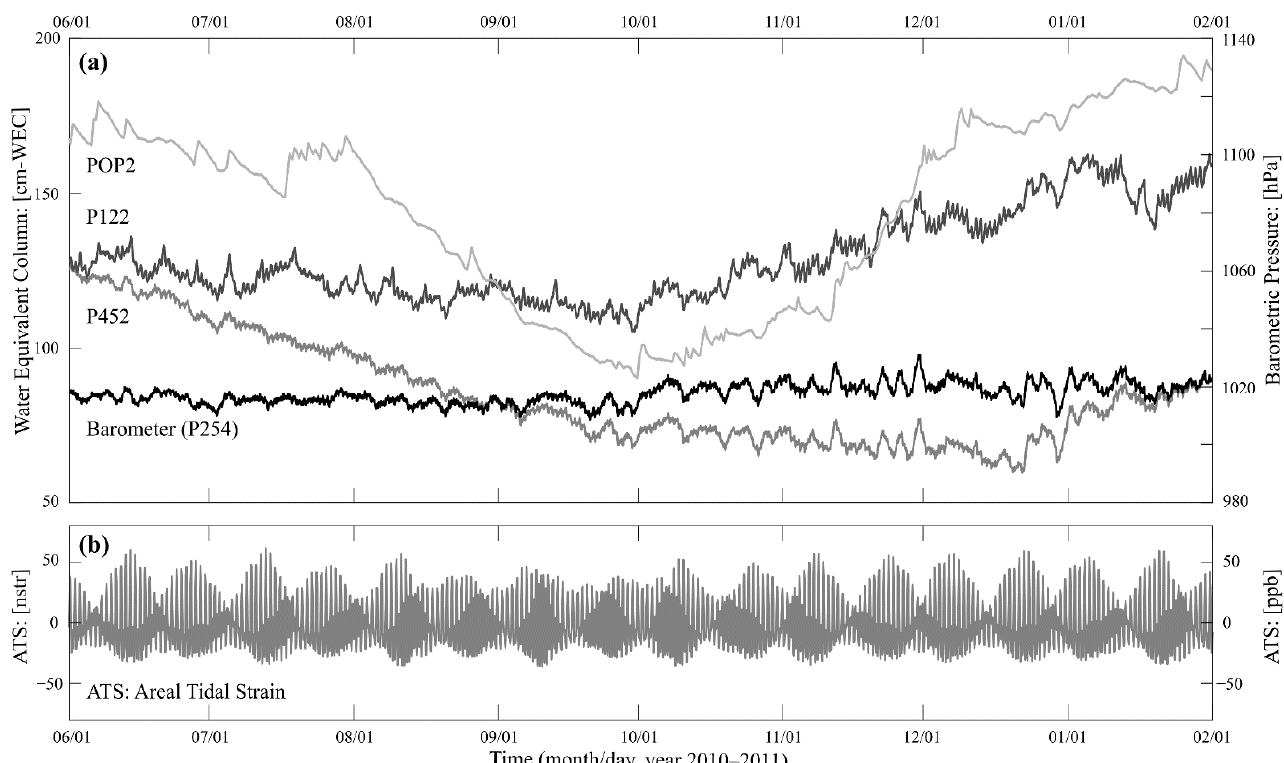
Figure 3. ( a ) Records of water level (P452, P122, and POP2) and barometric pressure (P254) in terms of centimeters of Water Equivalent Column (cm-WEC) and hectopascals. ( b ) Calculated tidal strain (P254) expressed as nanostrain (1 nstr = 1 ppb).